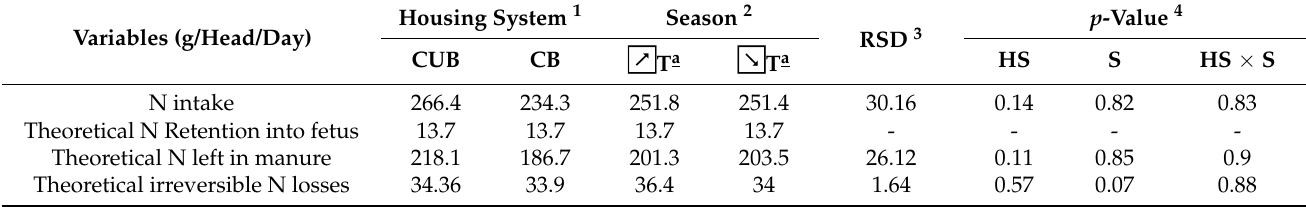
Table 1. N balance (g/head/day) and N emission in dry-pregnant cows in two housing systems and two seasons. Variables (g/Head/Day)